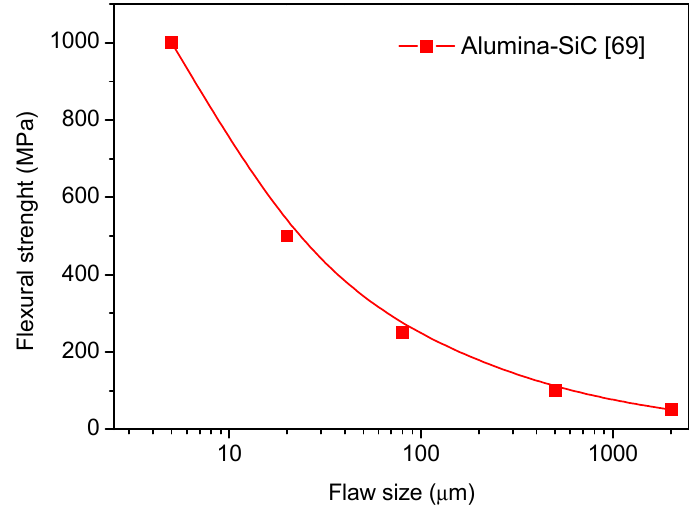
Figure 8. Evolution of flexural strength with the flaw size in Al 2 O 3 /SiC composites